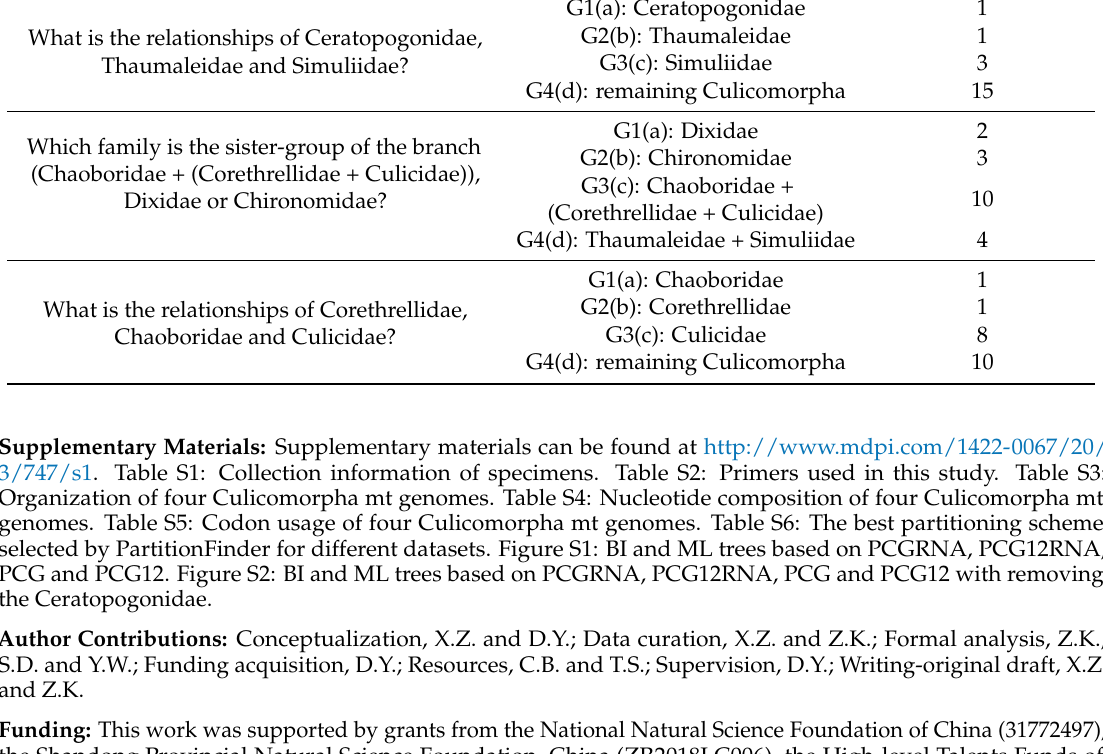
Table 2. The three datasets designed to evaluate three phylogenetic questions of Culicomorpha.